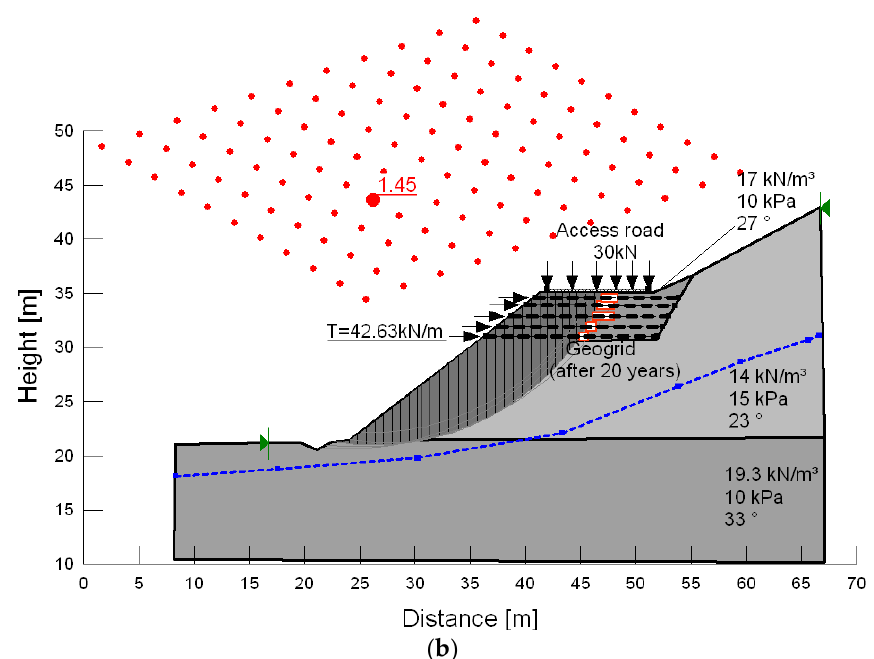
Figure 8. Slope stability analyses for ( a ) newly built geogrid of nominal tensile strength of 9.61 kN/m, and ( b ) geogrid after 20 years (measured tensile strength of 42.63 kN/m).